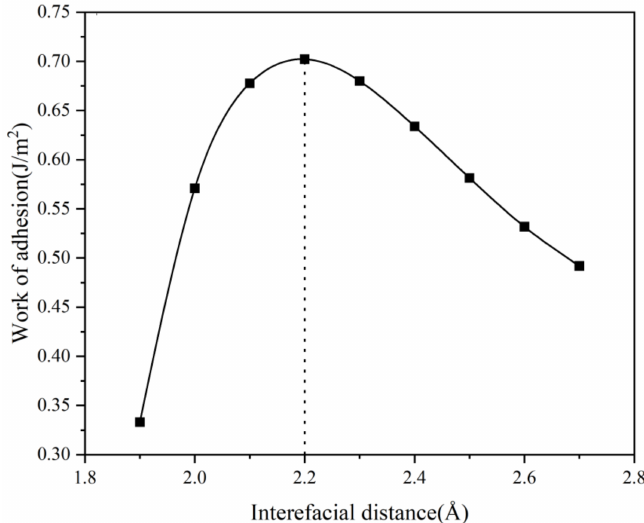
Figure 3. The relationship between the unrelaxed segregation distance ( d 0 ) and the work of adhesion ( W ad